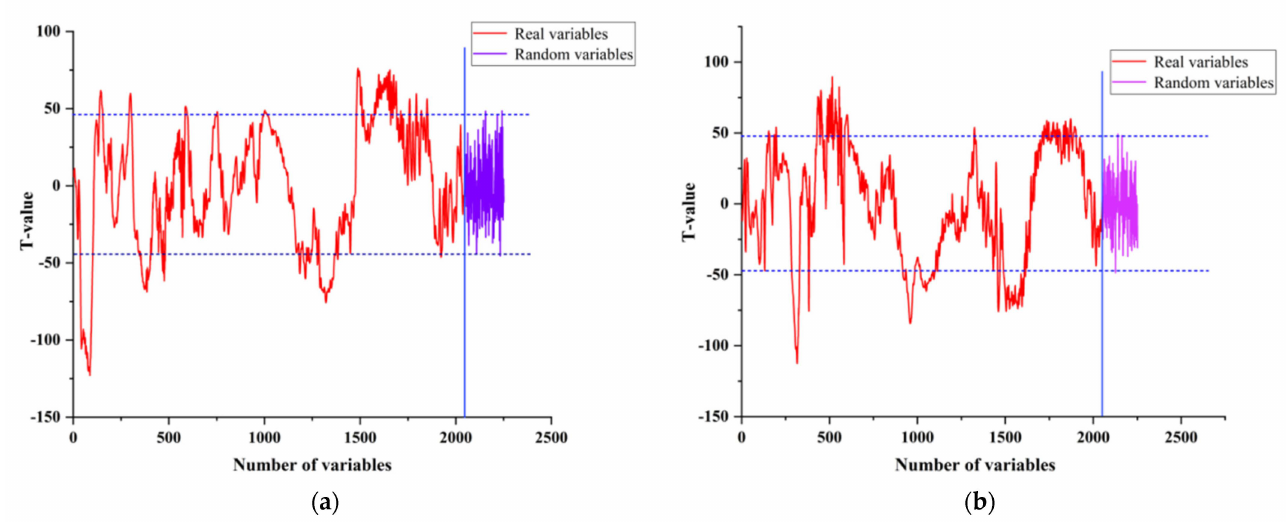
Figure 8. UVE-based selection of pear soluble solids content (SSC) ( a ) and acidity (pH) ( b ) fea- ture